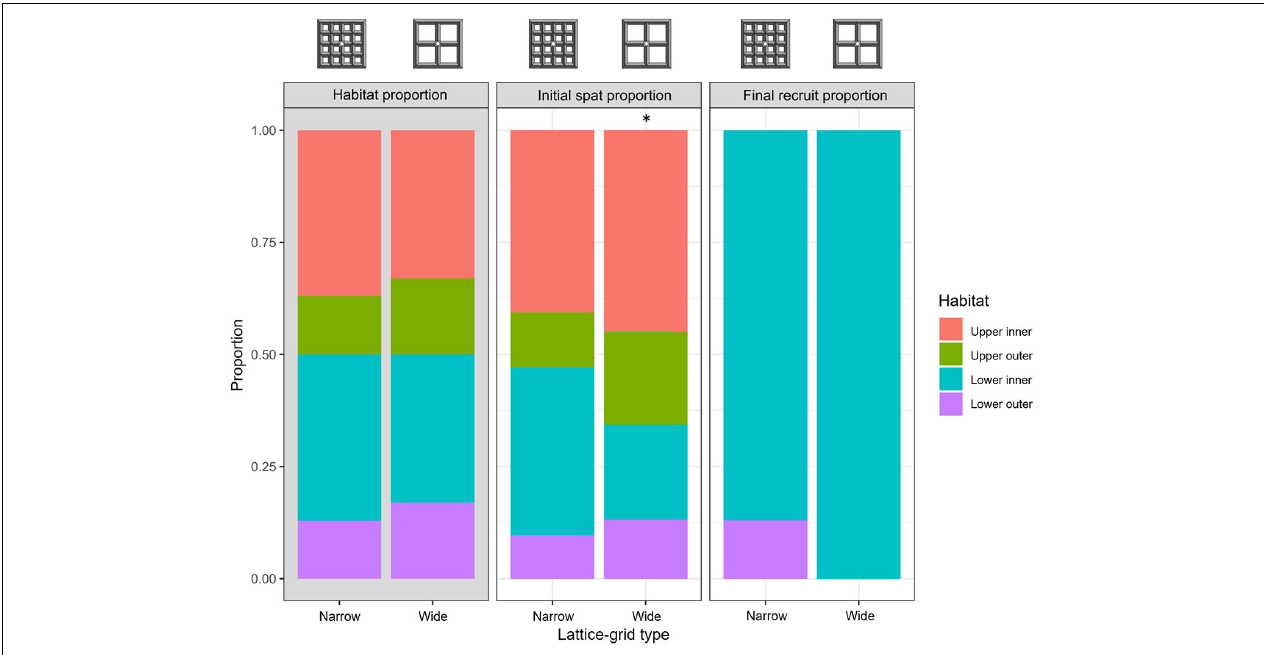
FIGURE 3 | Proportion of space available within each habitat type (grey plot, ‘Habitat proportion’), the proportion of live Acropora tenuis spat within each habitat type immediately after settlement (‘Initial spat proportion’) and the proportion of live A. tenuis juveniles approximately 1 year post-deployment (‘Final recruit proportion’) on two types of lattice-grids. Reference diagrams of each device type are included above the plots. Asterisk indicates a statistically significant difference in the observed and expected settlement proportions based on a Chi-square goodness-of-fit test ( p <